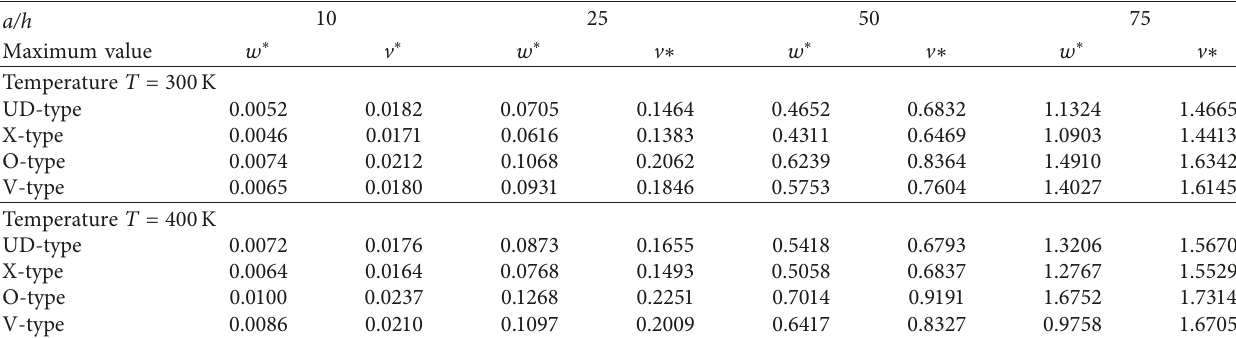
Figure 8: Influence of a/h ratio on nondimensional deflection, velocity, and stress of the center point at T (a) deflection w Table 6: Influence of a/h ratio on the nondimensional deflection, velocity, and stress of the centroid point a/h